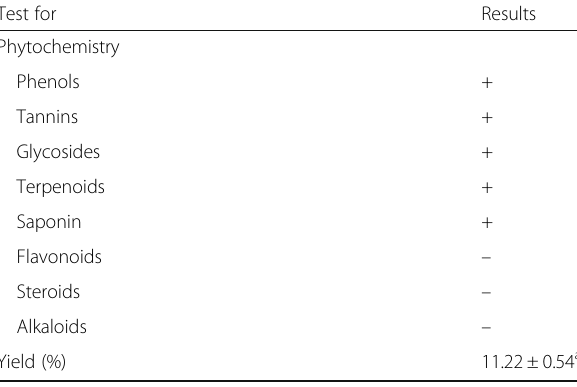
Table 1 Phytochemical screening and yield of the aqueous extract of C. cainito stem